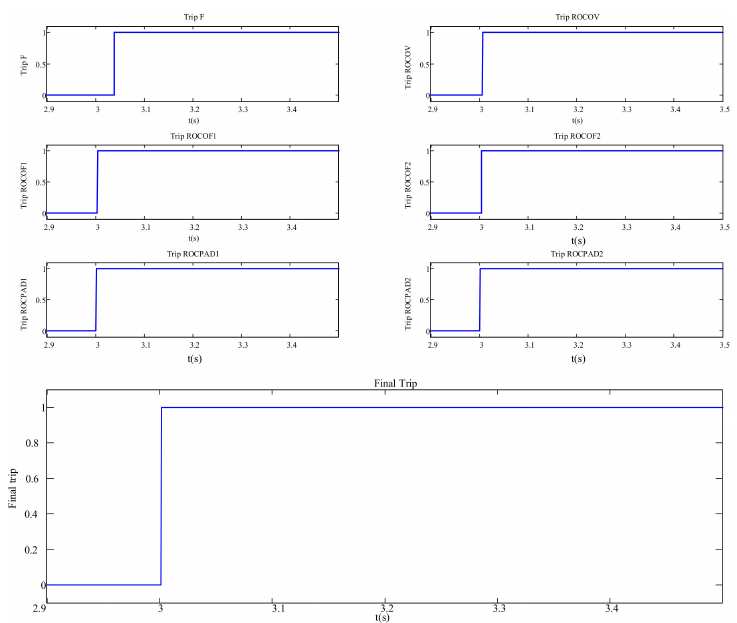
Figure 10. Trip signal of relays and the proposed algorithm in islanding mode with high power mismatch.